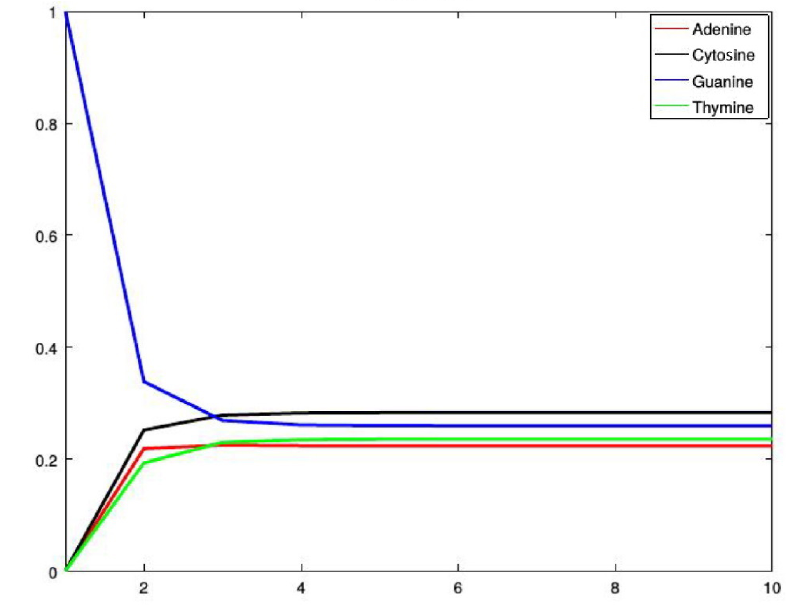
Figure 4. Probabilities of occurrences of the bases in consecutive steps starting from guanine.